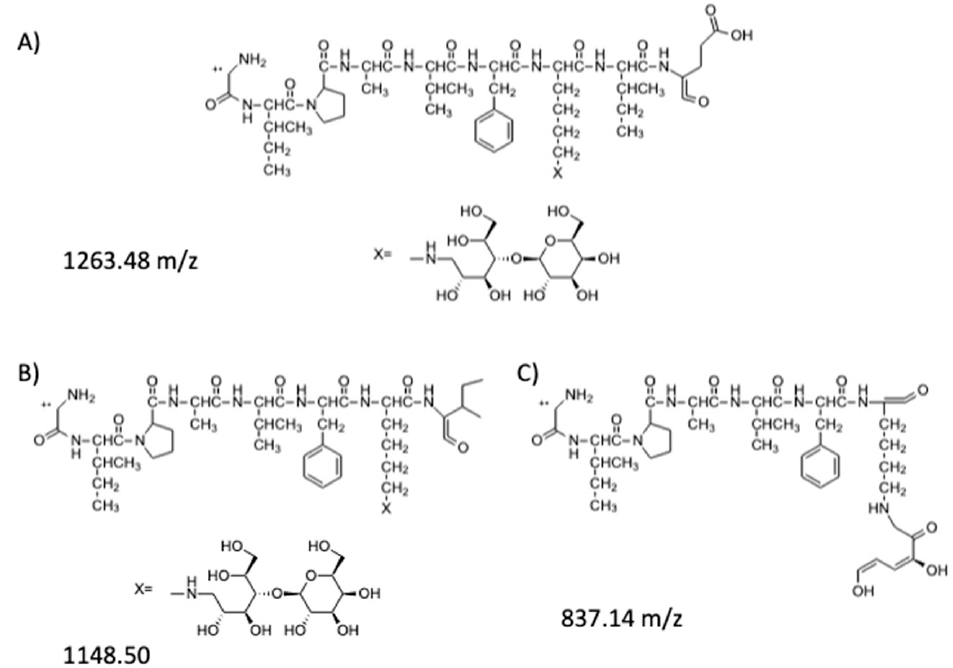
Figure 6. Fragments of the mono-lactosylated peptide identified in the MS 3 spectrum: ( A ) hypothesized structure for fragment at 1263.48 m / z ; ( B ) hypothesized structure for fragment at 1148.50 m / z ; ( C ) hypothesized structure for fragment at 837.14 m / z .